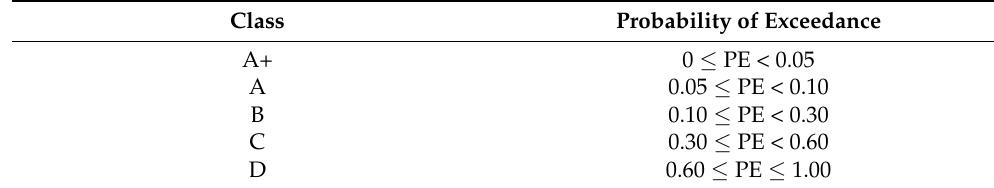
Table 1. Proposed seismic risk classes for nonstructural elements in terms of the probability of exceedance